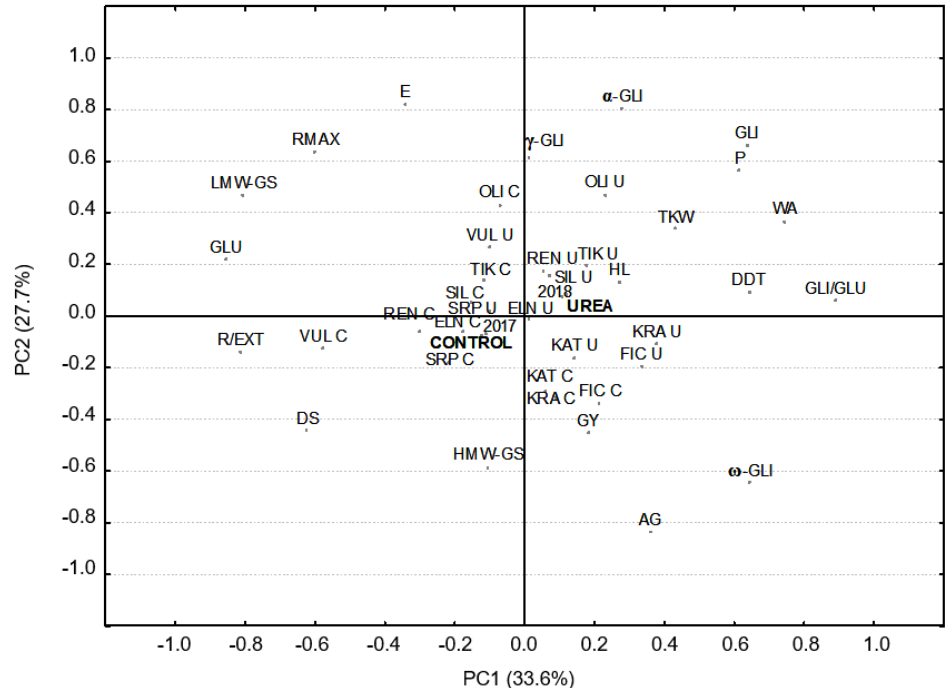
Figure 1. Biplot relative to the principal component analysis performed on grain yield, bread-making quality and proteins traits (GY—grain yield; TKW—thousand kernel weight;